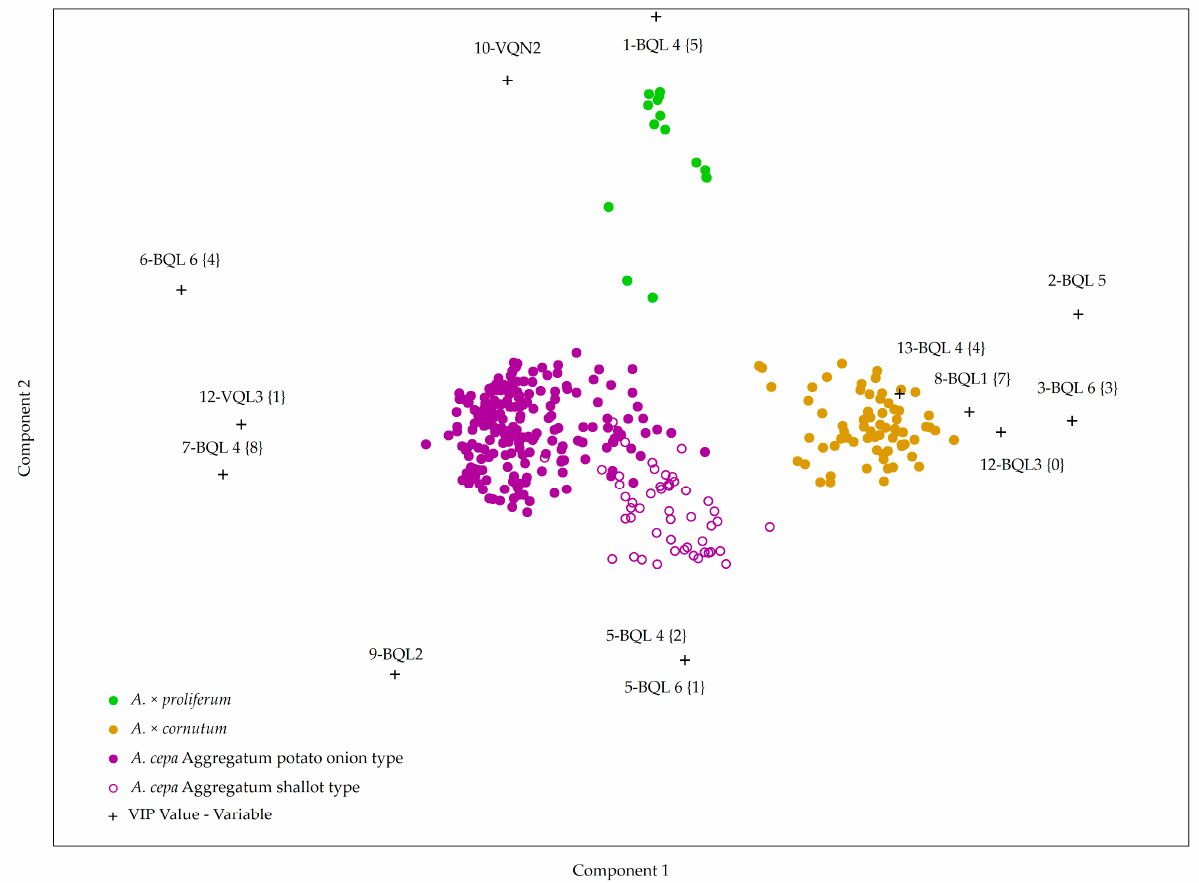
Figure 4. Partial Least Squares Discriminant Analysis (PLS-DA) biplot of comprehensive ex situ collection of Croatian accessions based on qualitative and quantitative vegetative and bulb morphology descriptors (VQL, VQN, BQL, and BQN). Ten individual plants per accessions were measured; each dot in the biplot represents one individual measure- ment.